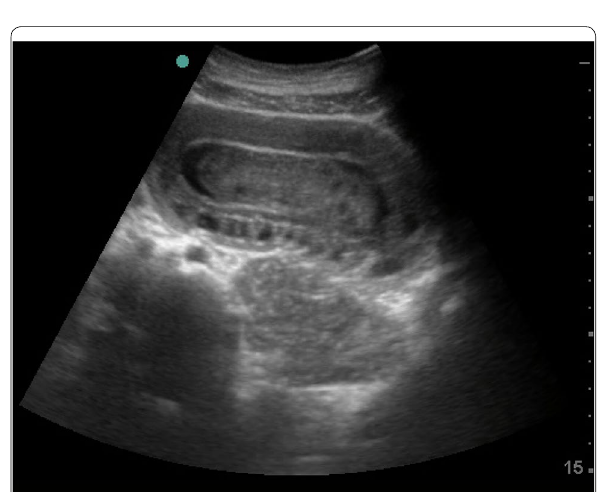
Fig. 2 Point of care ultrasound for acute abdomen (ACUTE approach) showed bowel telescoping inside itself with edematous bowel loop wall (long